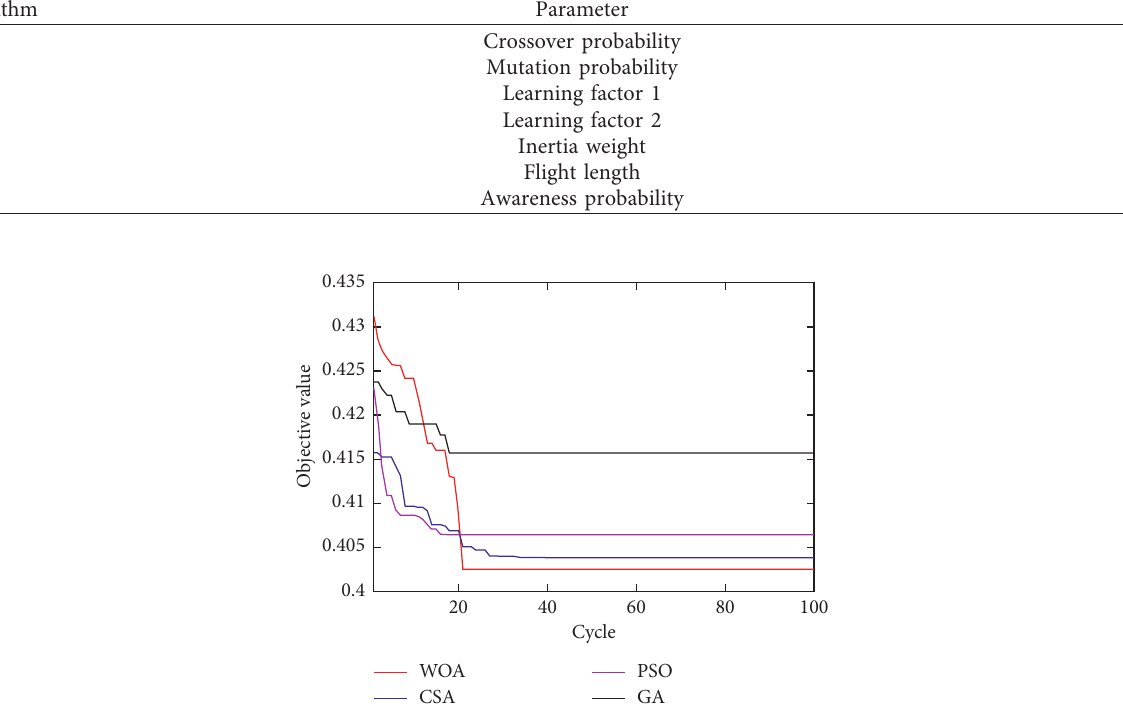
Figure 5: Convergence curves of the best solutions for different algorithms. Table 6: Comparison of objective values among different